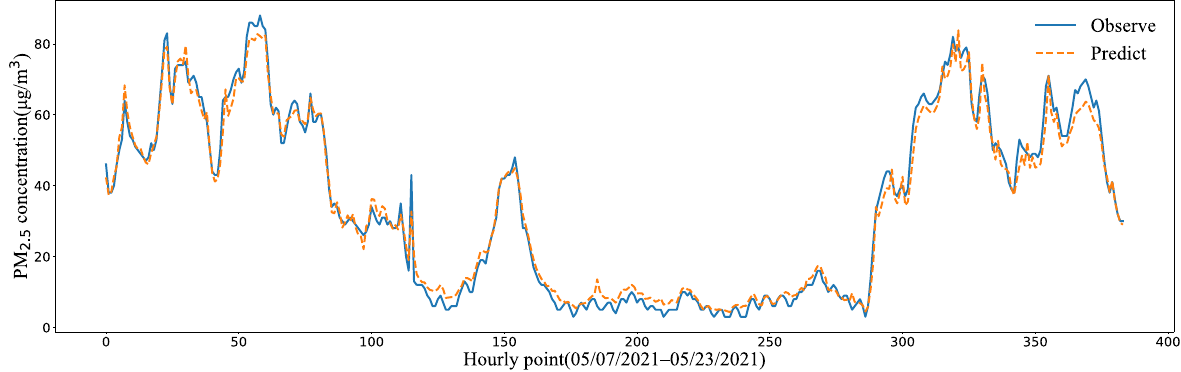
Figure 9. Prediction results for normal changes in PM2.5 concentration.